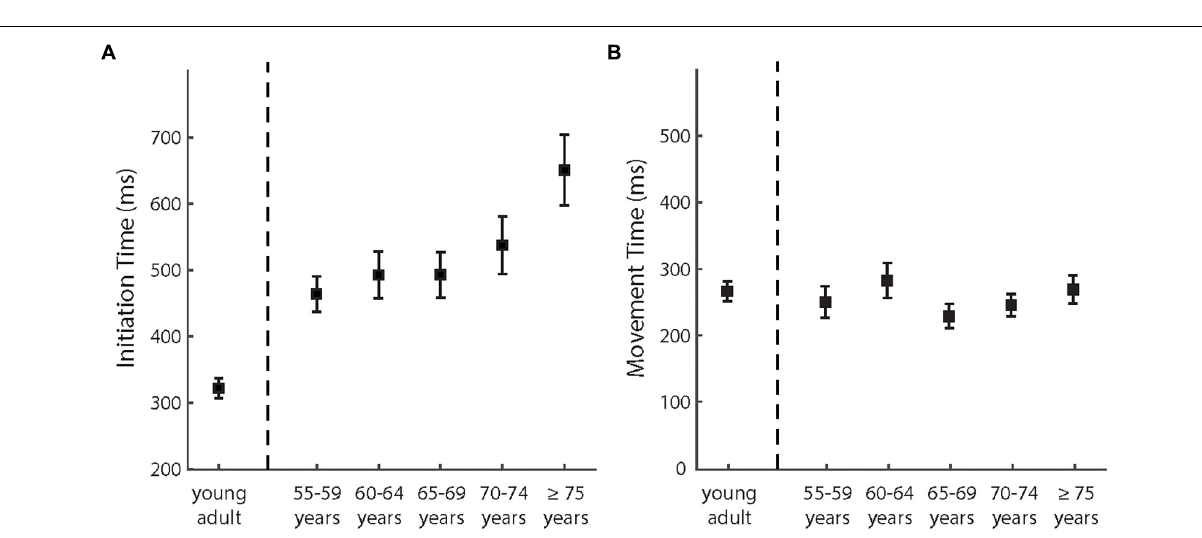
comparing models with/without a direct path between age and adaptive angular deviation ( Figures 8A,B